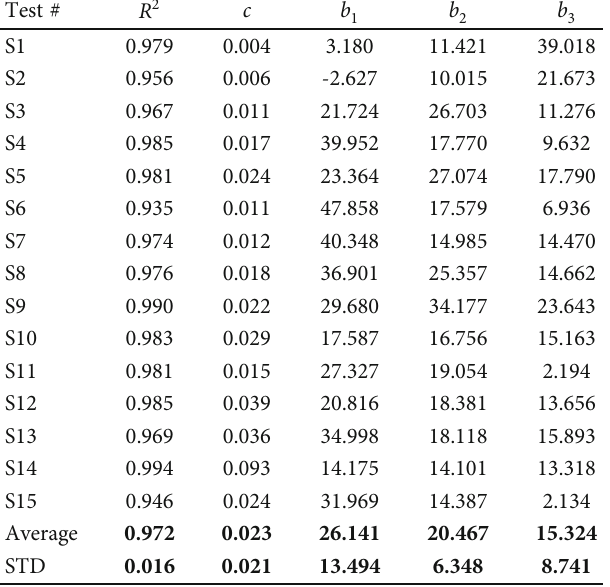
Table 4: Estimated material parameters of porcine sclera soft tissue loaded biaxially using Holzapfel (2000) hyperelastic constitutive model including the coe ffi cient of determination ( R 2 ) of each specimen ( N = 15 ). The average constitutive ( c , b 1 , b 2 , b 3 , and R 2 ) parameters are also